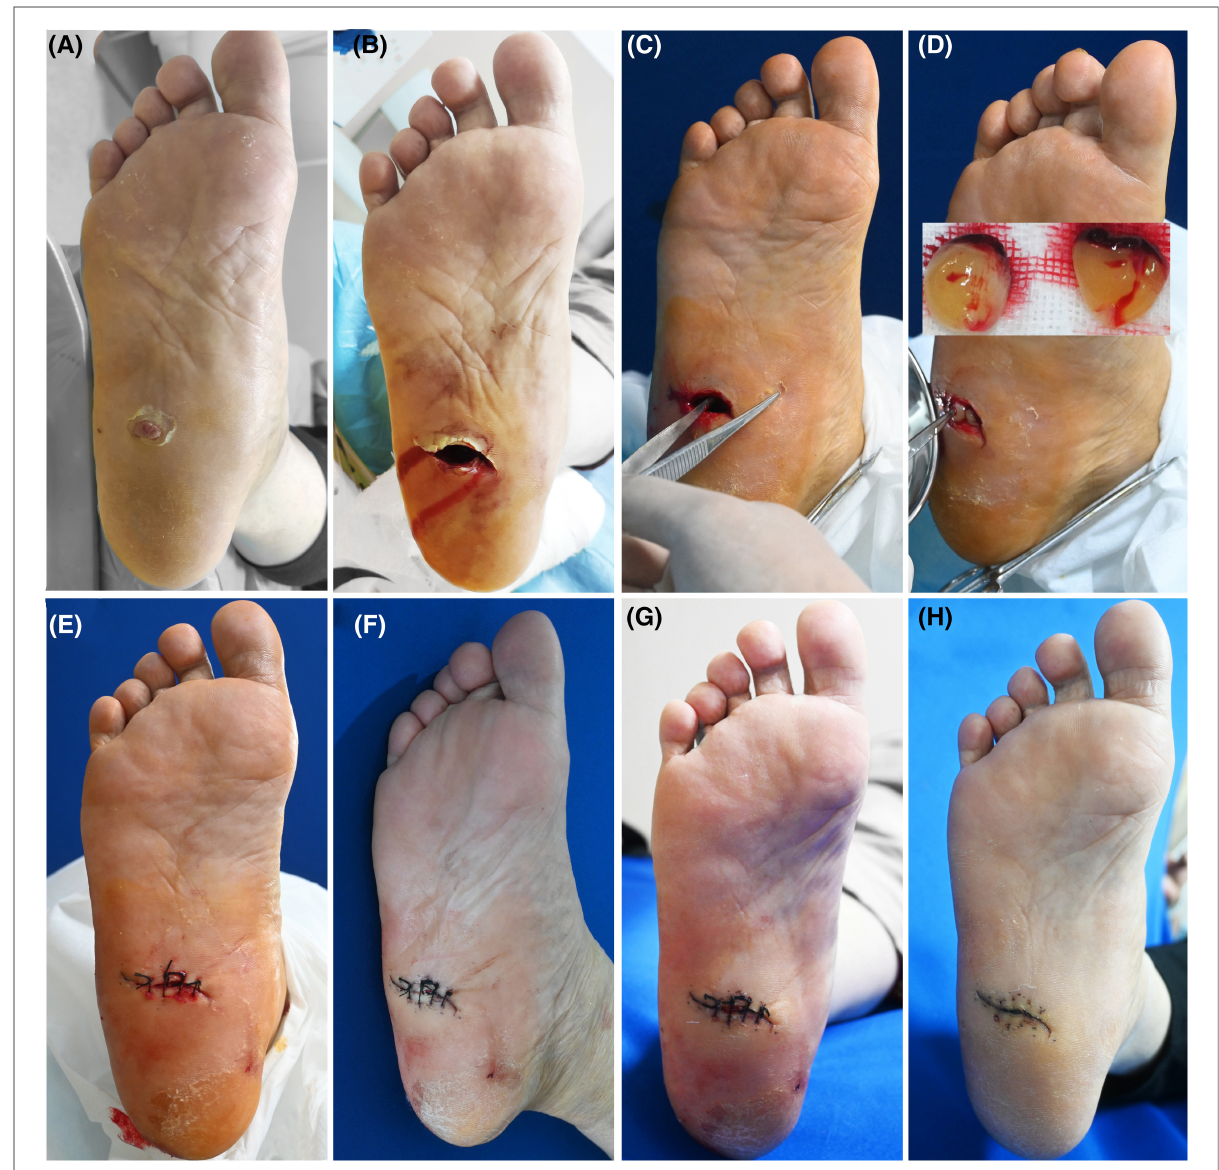
FIGURE 2 Patient 2. A 57-year-old female was stabbed by bamboo stubble on her right plantar for more than 2 months. ( A ) Baseline. ( B ) Sinus tract left after removal of the hyperproliferative granulation tissue. ( C ) Treatment day. The depth of the sinus tract was checked with sterile surgical forceps. ( D